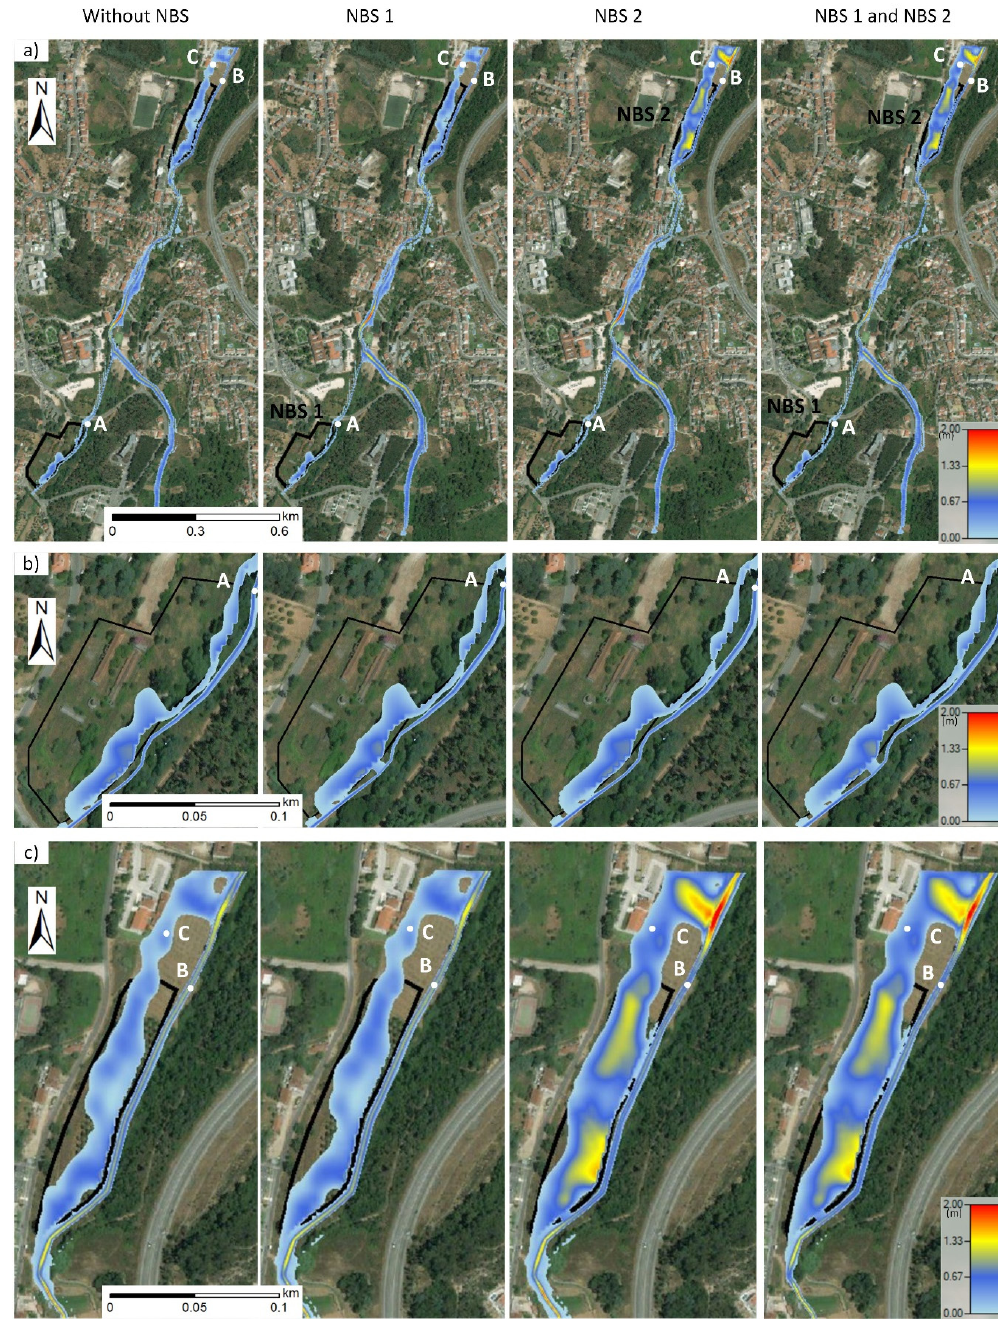
Figure 5. Flood depth maps for a return period of 100–year in four simulation scenarios (current situation without NBS, and implementation of NBS1, NBS2, and both NBS1 and NBS2), ( a ) showing all the drainage network within the study site, ( b ) with details on NBS 1 flooding area, and ( c ) with details on NBS2 flooding area. The letters A, B and C represent sites immediately downstream NBS1, at the catchment outlet, and on the floodplain immediately after NBS2, respectively. Although the extent of inundated areas increases with the installation of the NBS investigated, both NBS provide lower water height within the stream network, as shown in the site examples (single grids within the inundation map) present in Figure 6. At site A (see location in Figure 5),